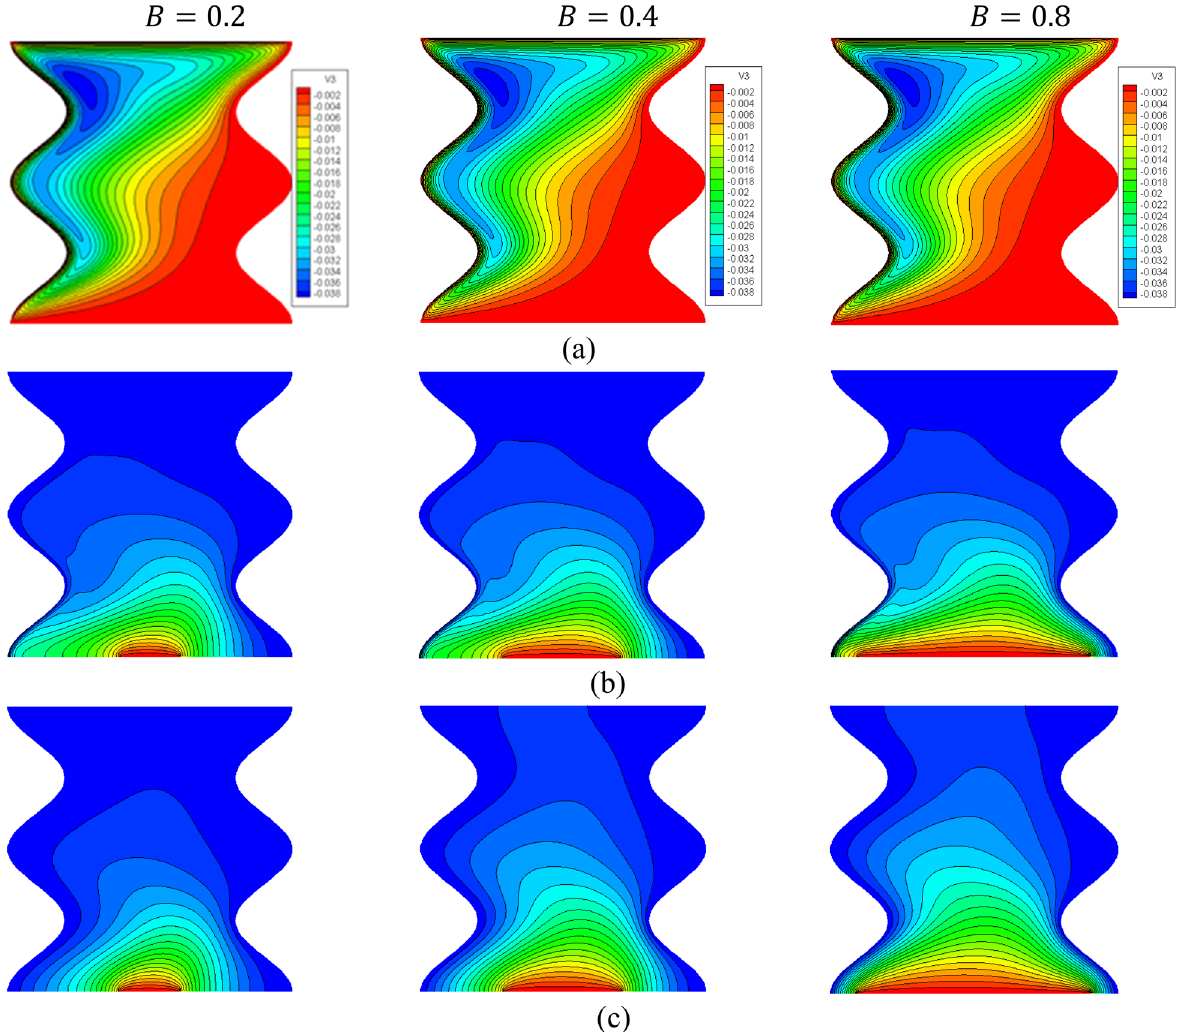
Figure 2. Contours of ( a ) streamlines, ( b ) isotherms of a fluid phase, and ( c ) isotherms of a solid phase below the changes on a partial heat length B for a hybrid nanofluid at φ Cu